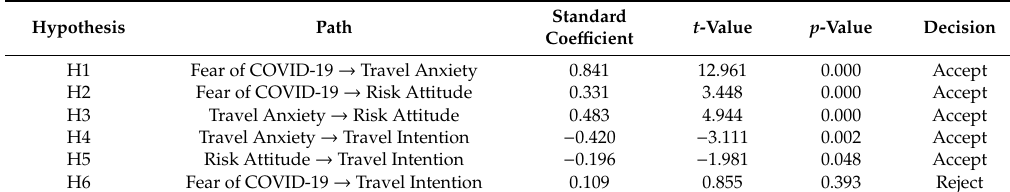
Table 4. Direct Path for the Structural Model.